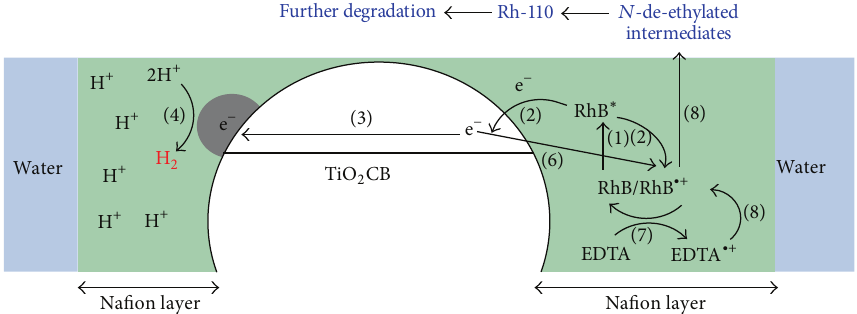
Scheme 1: Schematic illustration of the simultaneous production of H 2 and degradation of RhB occurring on Pt/TiO 2 /Nf. (1) excitation of RhB, (2) electron transfer from excited RhB to TiO 2 CB with RhB ∙+ generation, (3) electron transfer from TiO 2 CB to Pt nanoparticles, (4) reduction of protons (H 2 production), (6) electron transfer from TiO 2 CB to RhB ∙+ (charge recombination) with RhB regeneration, (7) electron transfer from EDTA to RhB ∙+ with EDTA ∙+ generation and RhB regeneration, and (8) reaction between RhB ∙+ and EDTA ∙+ ( 𝑁 - deethylation of RhB). The number in parentheses indicates the number of reactions in the text.